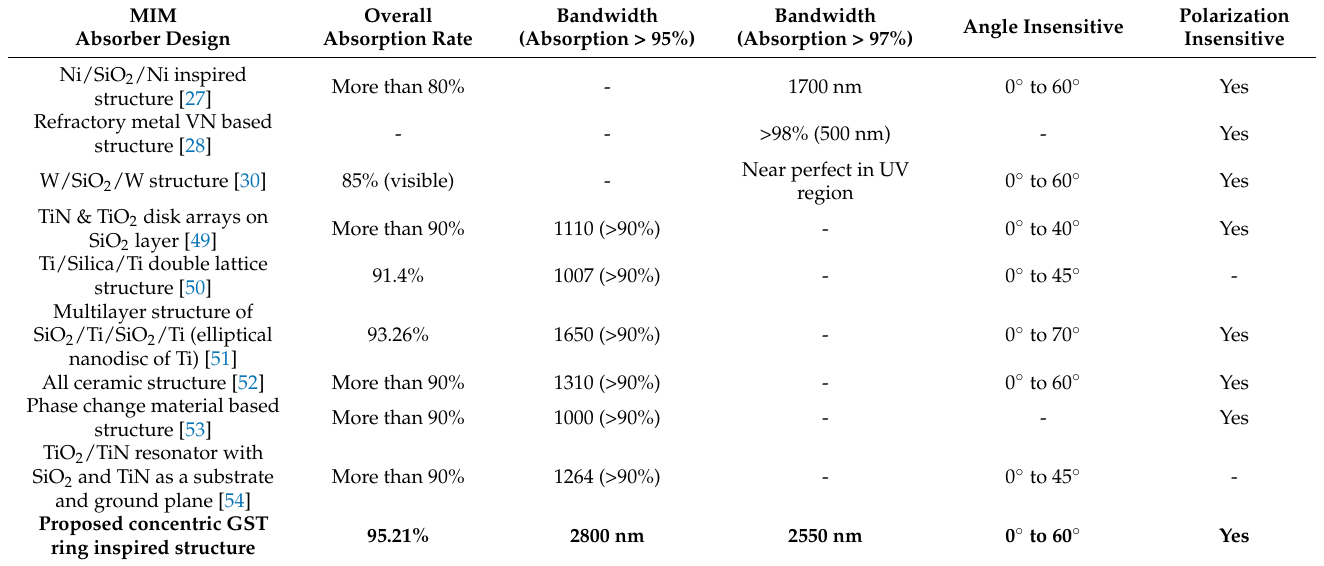
Table 1. Proposed Absorber’s Performance comparison with the available